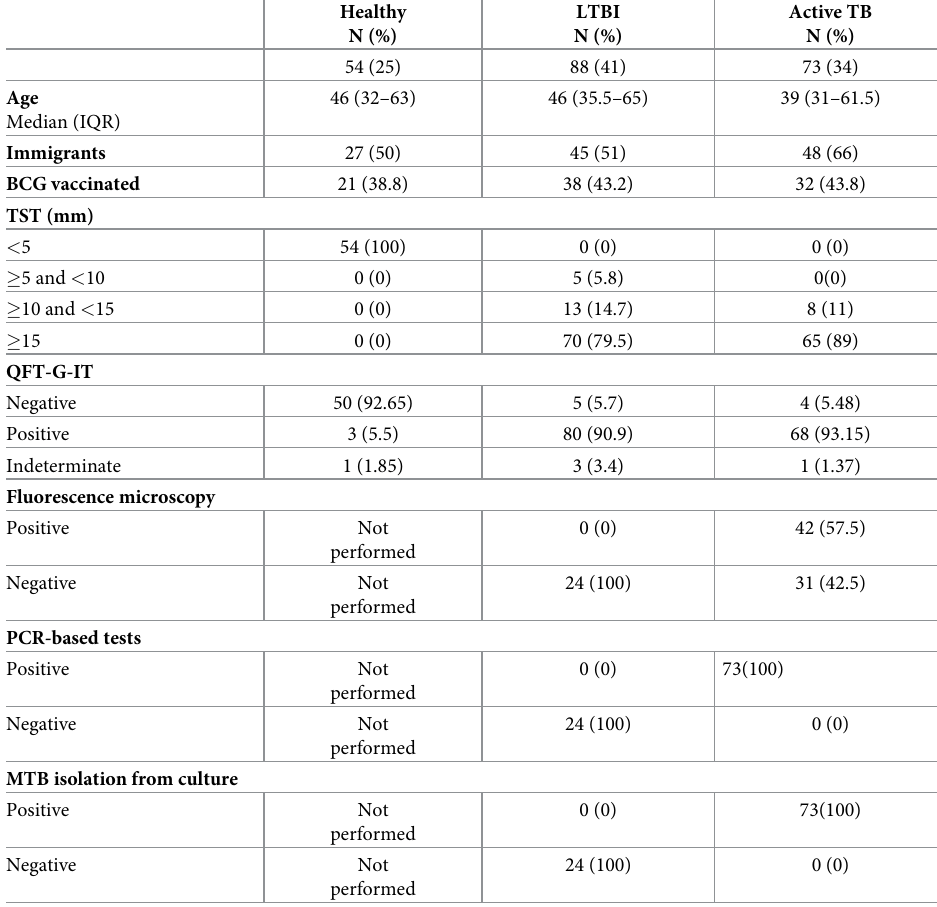
Table 1. Characteristics of the 215 subjects divided according to the diagnosis in the three study